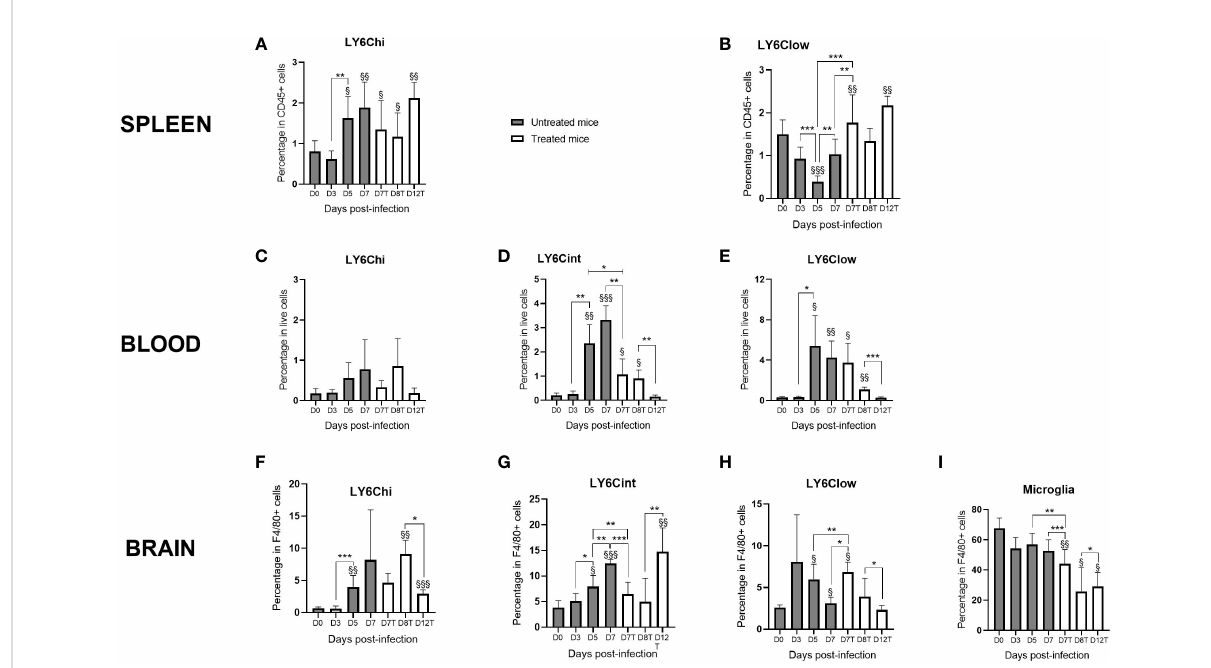
FIGURE 2 Monocyte subpopulations evolve differently in the spleen, peripheral blood, and brain during infection and resolution in response to chloroquine (CQ) treatment. The spleen, blood, and the brain were sampled at different time points of infection with the Plasmodium berghei ANKA strain in CQ-treated and untreated mice. Monocyte subpopulations, as well as the microglia, were identi fi ed and quanti fi ed from live cells by fl ow cytometry using FlowJo. (A, B) Percentages of Ly6C hi (A) and Ly6C low (B) monocytes in the spleen in treated and untreated mice. (C – H) Three percentages of the monocyte subpopulations in the peripheral blood (C – E) and in the brain (F – H) during kinetics in treated and untreated mice. (I) Percentage of the microglia during kinetics. The results are presented as curves and bars for better visualization of the kinetics and the signi fi cant differences. For each subpopulation, one-way ANOVA fi rst con fi rmed that the means were not equal before two-by-two comparisons using an unpaired two-tailed Students t -test. Signi fi cant differences between consecutive time points are shown with an asterisk , while differences from day 0 (D0) are shown with a section symbol . One symbol denotes p < 0.05, two symbols p < 0.005, and three symbols p <